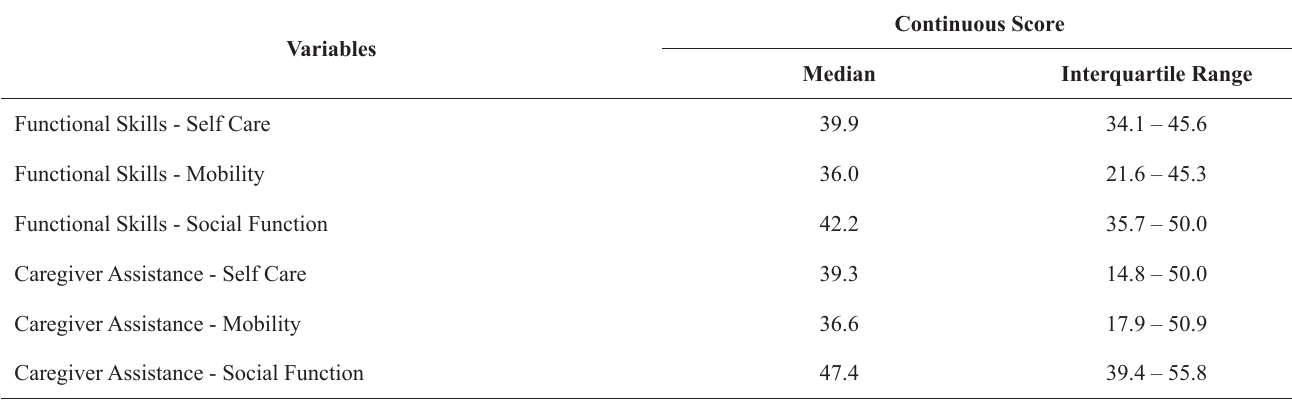
Table 3 - Functional skills and caregiver assistance in the dimensions of self-care, mobility and social function (n = 74)